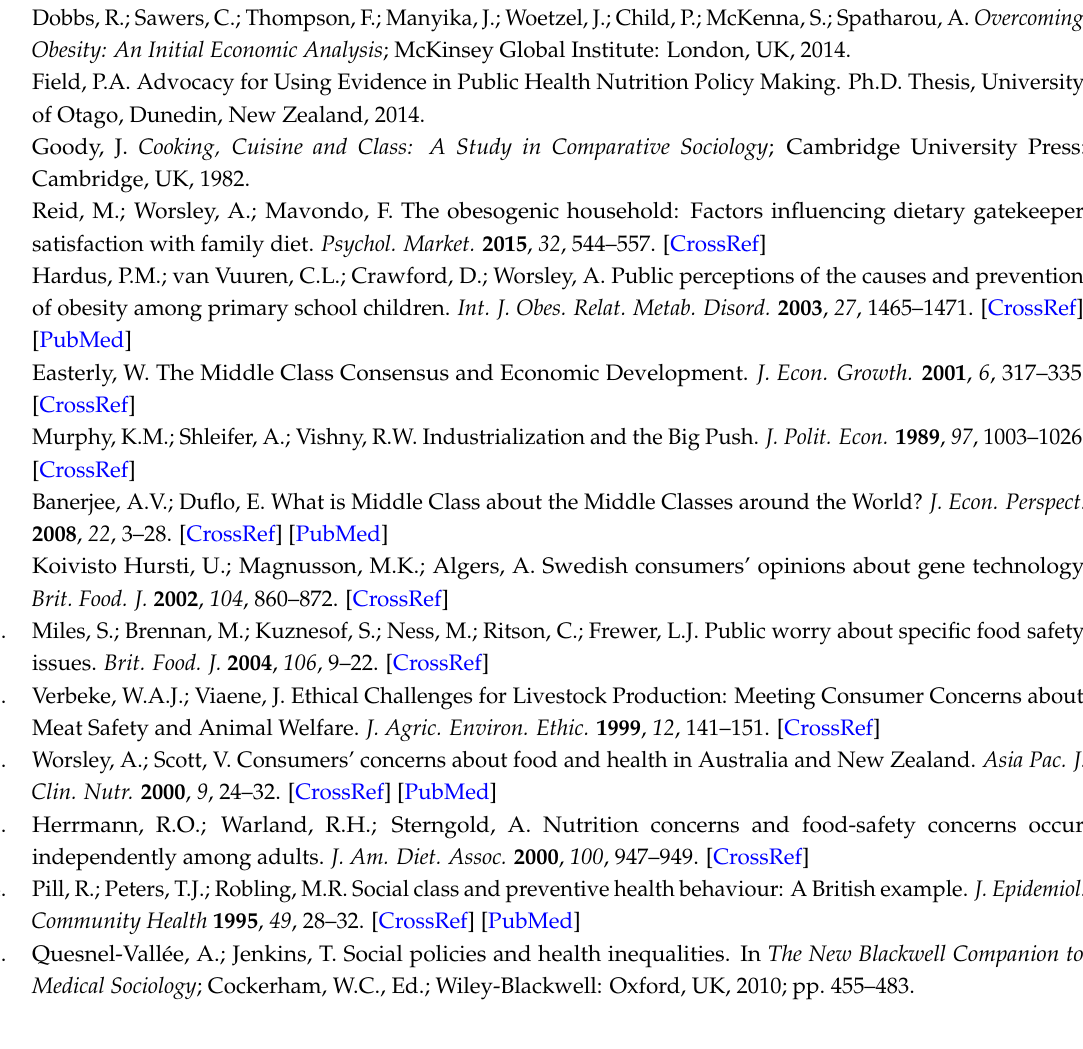
Table S1: Food Providers’ views of the causes of obesity, Table S2: Food Providers’ perceptions of the views of the effectiveness of ways to maintain body weight, Table S3: Adaption of Portrait of Values, Structural Equation Model: Analytical